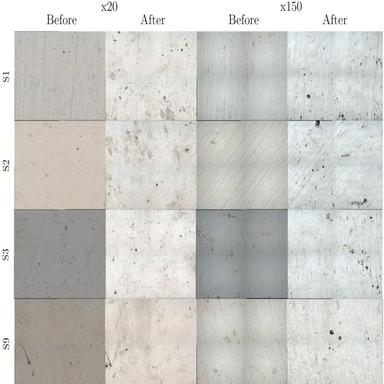
Inconel 625, combined laser and optical images obtained by 3D profilometry before and after testing.